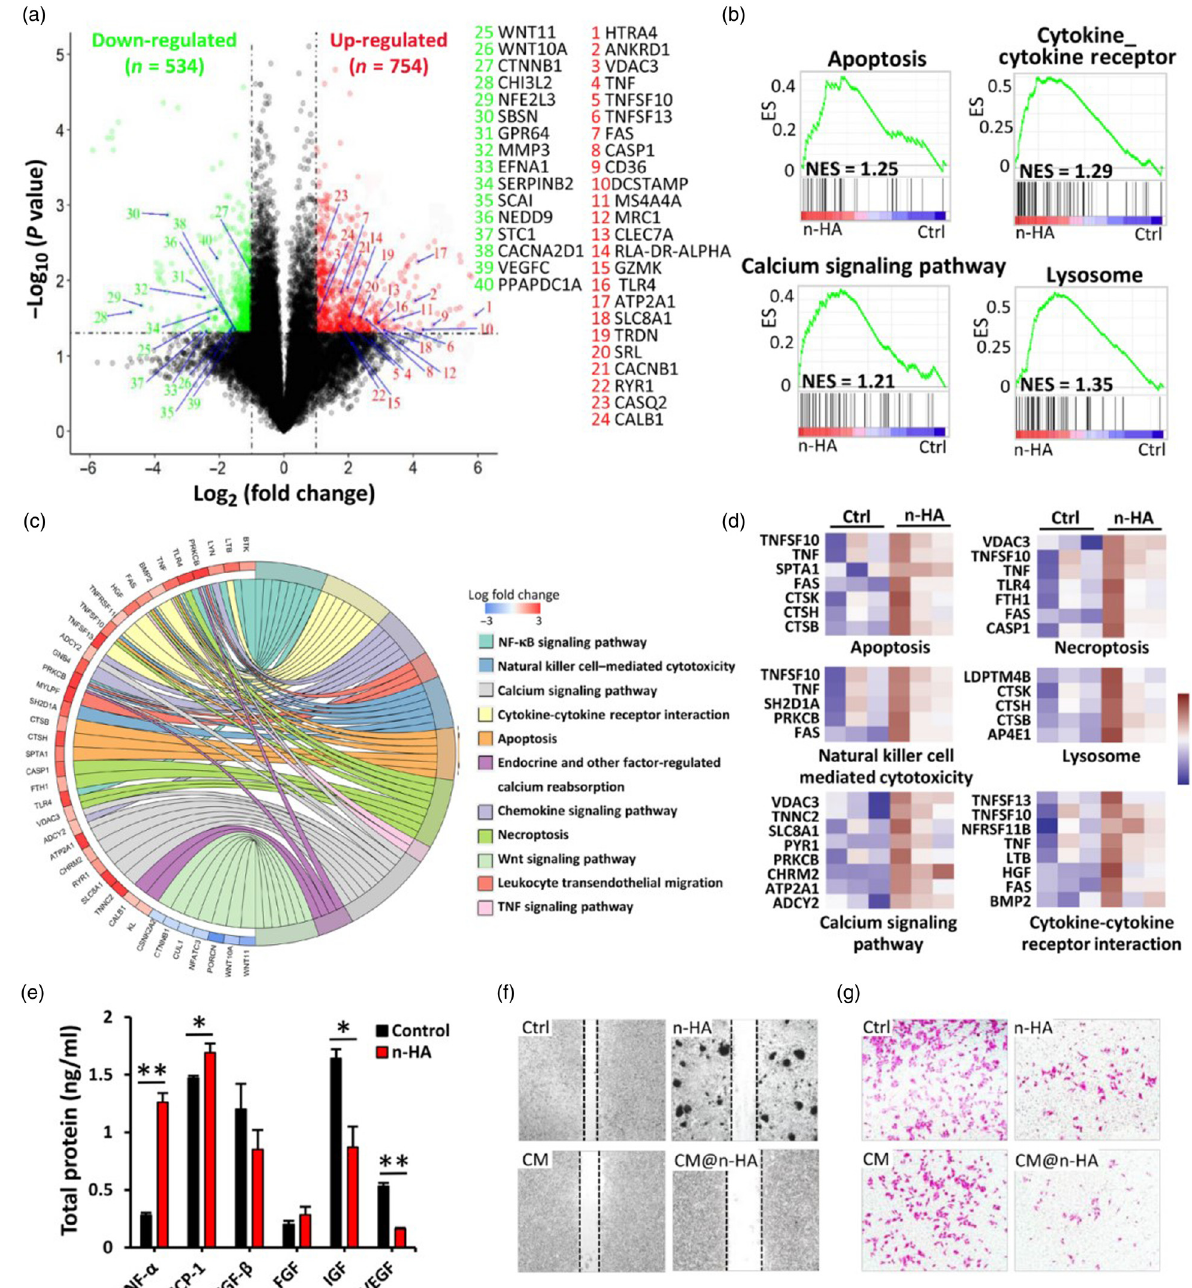
Figure 5: Nano - HA regulates gene expressions related to tumor suppression, calcium homeostasis, and immune response. ( a ) Volcano plot showing di ff erentially regulated genes in the n - HA - treated tumor tissue as compared to the nontreated control. ( b ) Gene set enrichment analysis of the regulated gene pathways with the Kyoto Encyclopedia of Genes and Genomes database. ( c ) Circular visualization of the results of gene - annotation enrichment analysis. ( d ) Heat map of genes that were di ff erentially expressed in n - HA versus control tumor tissues. ( e ) Enzyme - linked immunosorbent assay of in fl ammatory cytokines. ( f ) Wound healing assay of mouse 4T1 tumor cells treated for 24 h. ( g ) Transwell assay after crystal violet staining showing serum - induced migration of 4T1 tumor cells treated for 24 h [ 65 ]